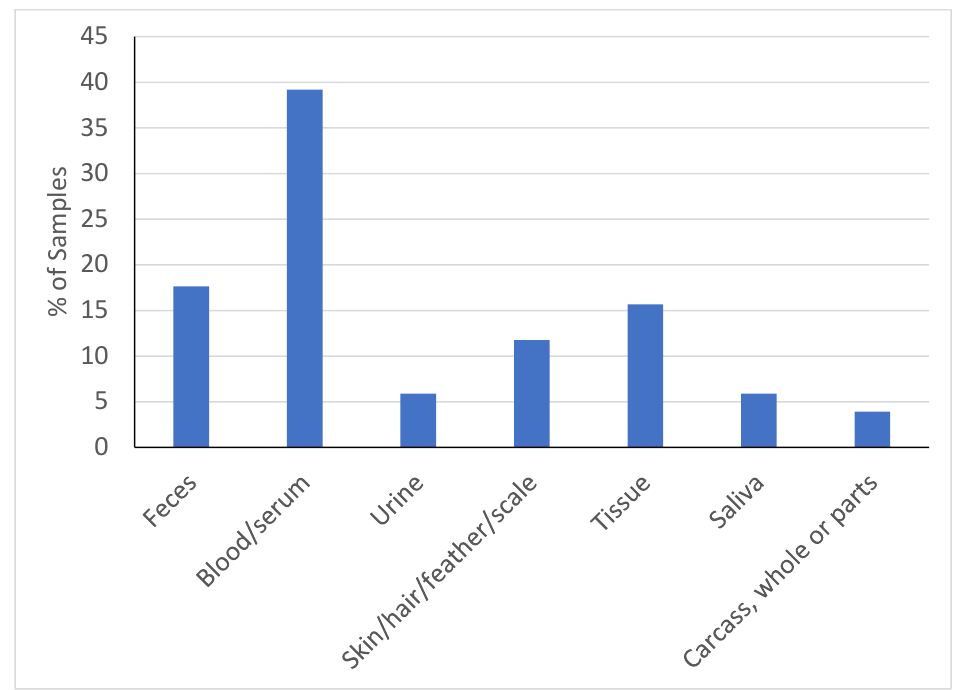
Figure 3. Percentages of different biomaterial types the Saint Louis Zoo agreed to provide to re- searchers in the period of